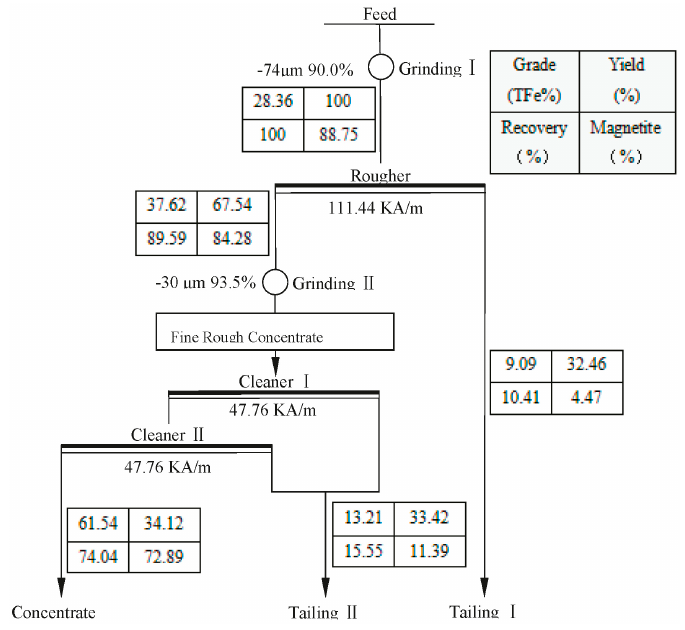
Figure 3. The quantity-quality flow-sheet of simple magnetic separation.